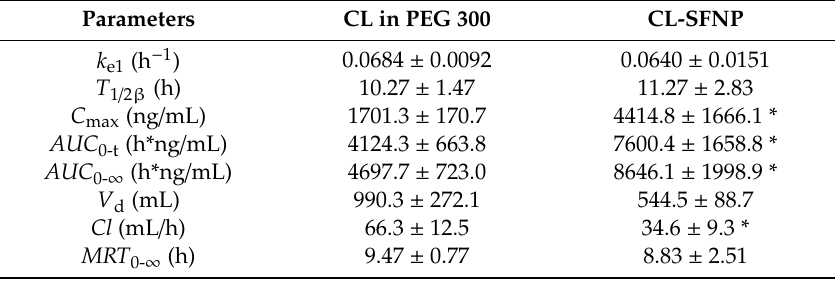
Figure 4. Mean concentration–time curves of CL after IV and PO administration of equivalent CL in pure CL and CL-SFNP (1 mg / kg and 3 mg / kg, respectively) in rats ( n = 3). Table 5. Pharmacokinetics parameters of CL after intravenous administration of pure CL and CL-SFNP at 1 mg / kg ( n =